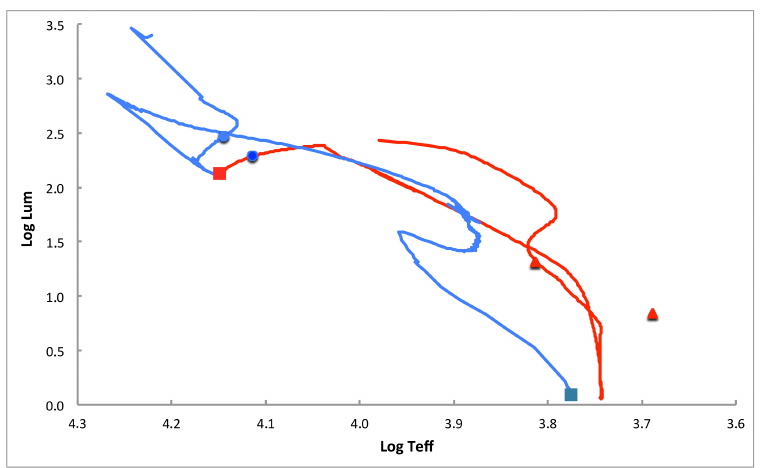
Figure 1. Hertzsprung Russell diagram (HRD) evolution of β Per. Starting at the red square, the donor follows the red path (observed and calculated positions: triangles). Starting at the blue square, the gainer follows the blue path close to the Main Sequence (observed and calculated positions: filled